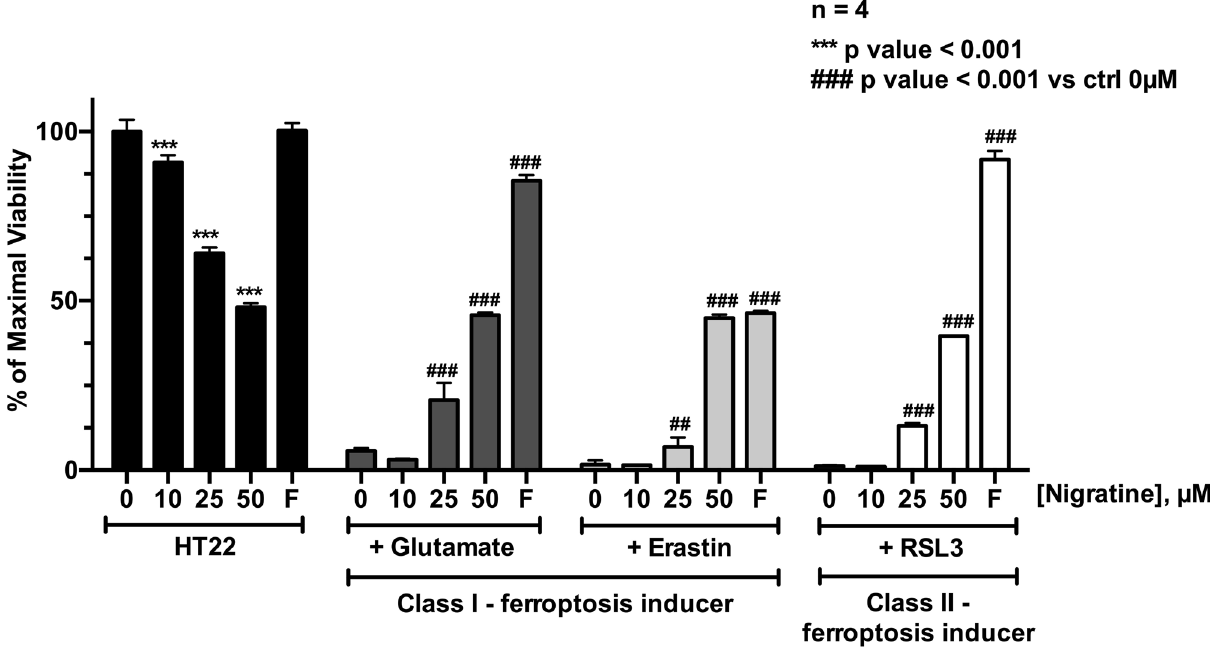
Figure 2. Nigratine protects HT-22 mouse hippocampal neuronal cell line from cell death triggered by both class I and II-inducers of ferroptosis. HT22 cells were treated 24 h with increasing concentrations (0–50 µM) of the tested chemical compounds alone (“HT22”) or co-treated with 5 mM glutamate, 0.5 µM erastin or 1 µM of RSL3. Ferrostatin-1 (“F”) was used as a positive control for ferroptosis inhibition. Cell viability was estimated by MTS assay. Data are shown as the mean ± SD of four